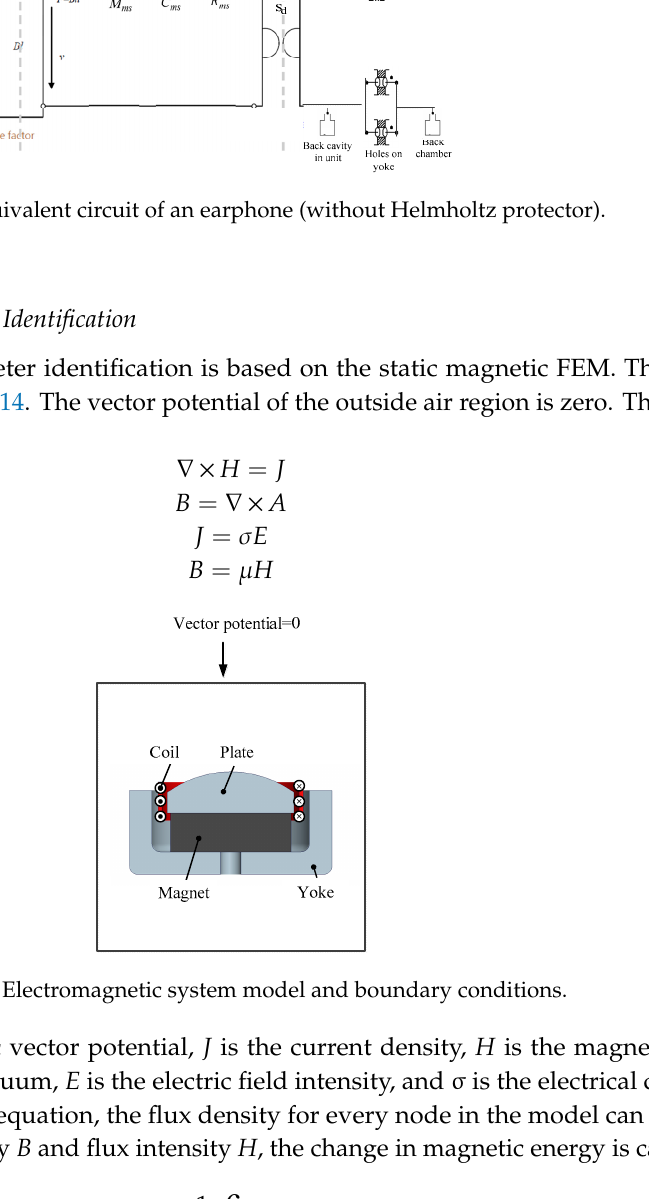
Figure 15. Mechanical system model and boundary conditions.